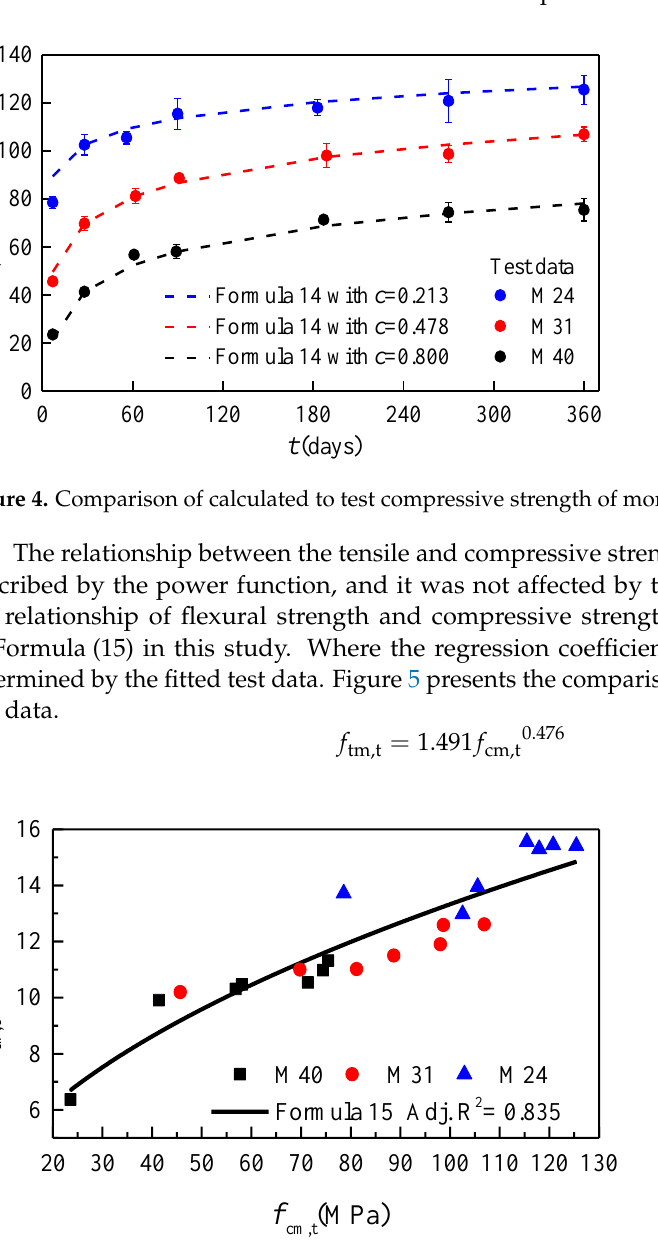
360 Test data Figure 6. Comparison of calculated to test flexural strength of mortars at different curing ages. 3.2. Characteristics on PL-S Curves of Steel Fiber at Different Curing Ages Figure 7 shows the characteristic PL-S curves of steel fiber in M40, M31 and M24 at different curing age. Similar shapes are presented on all characteristic curves. The peak pull-out loads, the slopes of ascending and descending portions gradually increase with the curing age. Especially the PL-S curves of M40 and M31 in 7 days are significantly flat- ting with lower peak loads compared with the curves after 28 days. This is consistent with the mortar strength development discussed above. 0